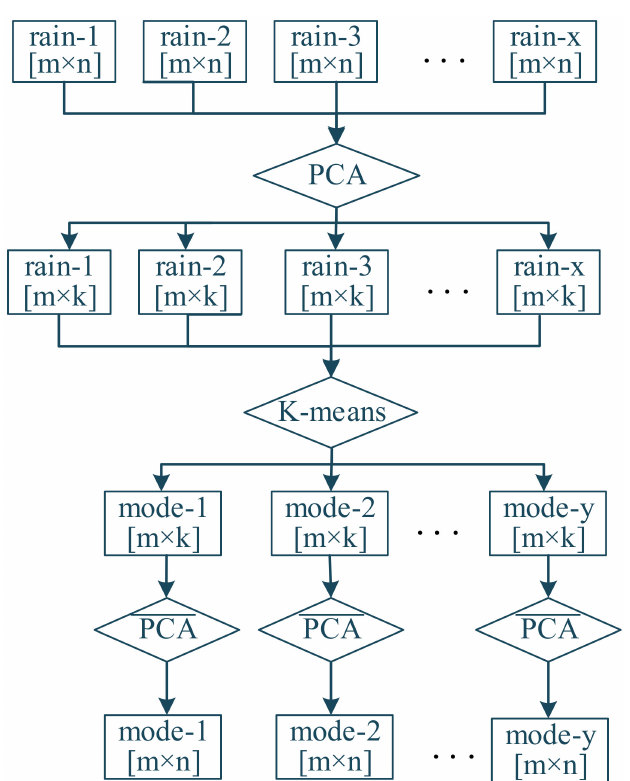
Figure 3. Flowchart for extraction of rainfall temporal and spatial